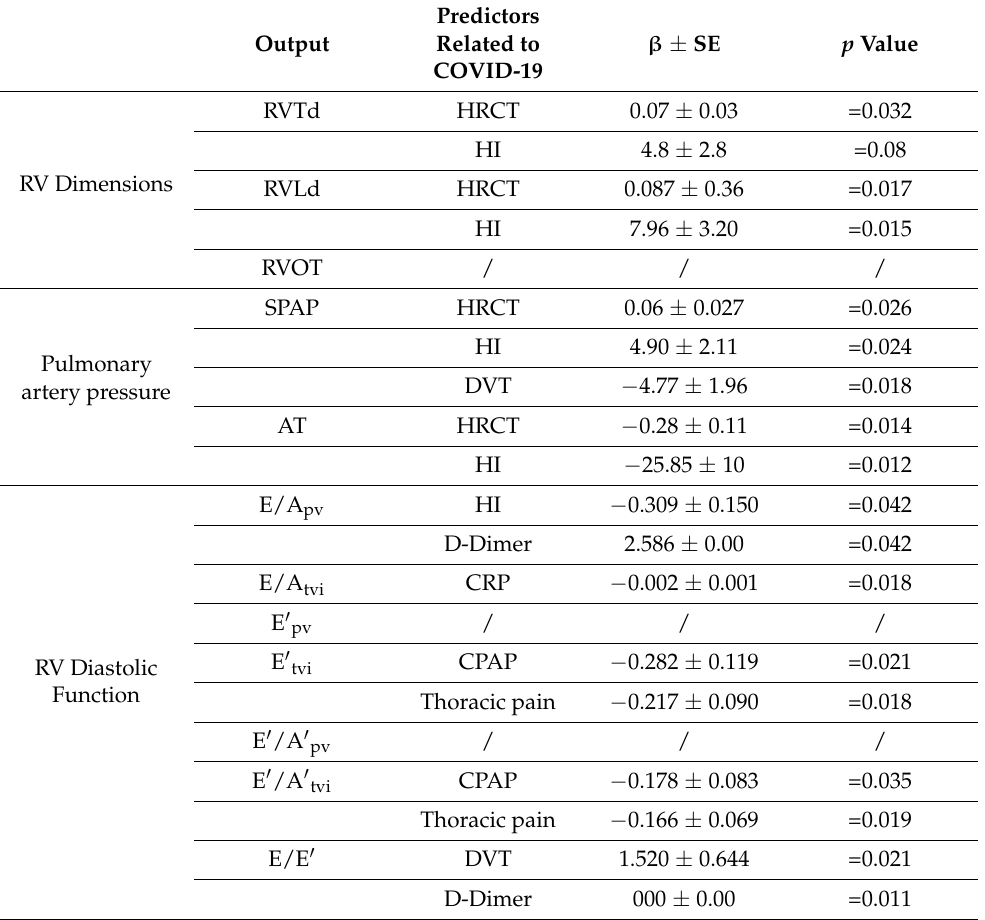
Table 4. COVID-19 alterations during the infection independently related to right ventricle and pulmonary artery pressure at the follow-up: backward regression